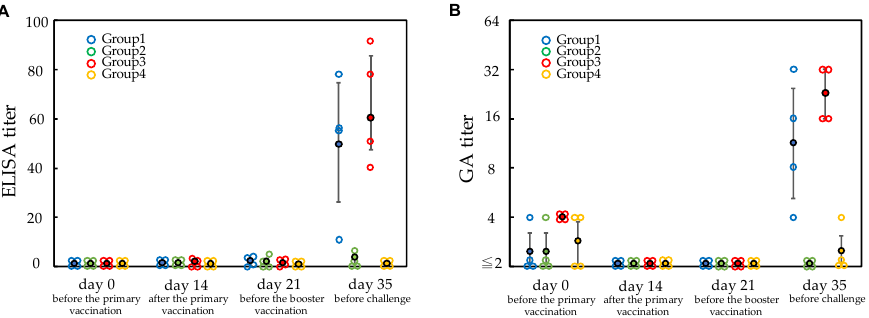
Figure 1. Antibody titers against Erysipelothrix rhusiopathiae measured using ELISA and the growth agglutination (GA) tests. The X -axis shows the blood collection at four time points; on day 0, just before the primary vaccination; on day 14, 2 weeks after the primary vaccination; on day 21, just before the booster vaccination; on day 35, just before the challenge. The Y -axis shows the antibody titers. Each antibody titer of pigs (open circle) and mean antibody titer (closed circle) of each group are shown. Each group of pigs is shown in separate color. Vertical line on the mean antibody titer indicates the ± SD error bar. ( A ) ELISA titers. ( B ) GA antibody titers.